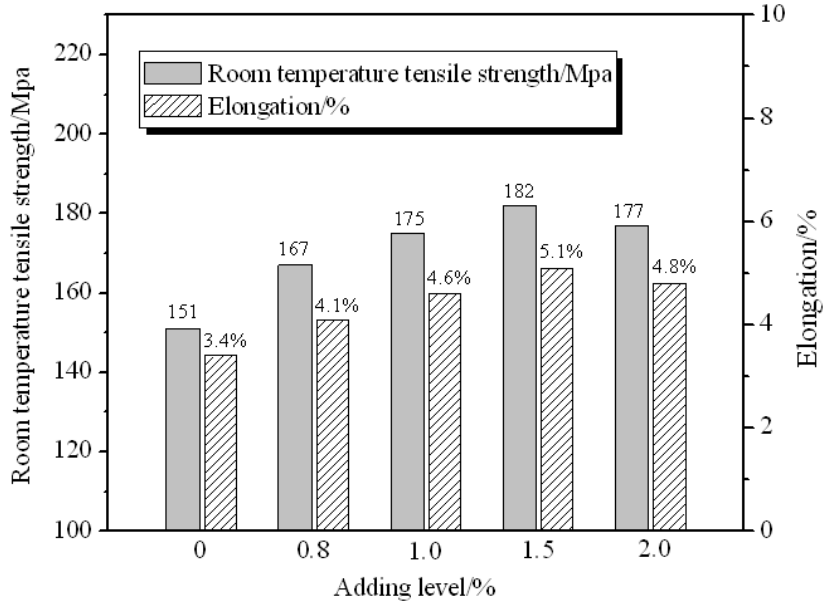
Figure 12. Tensile properties of Al-8Si alloy with different adding levels of Al-5Ti-0.62C-0.2Ce master alloy.